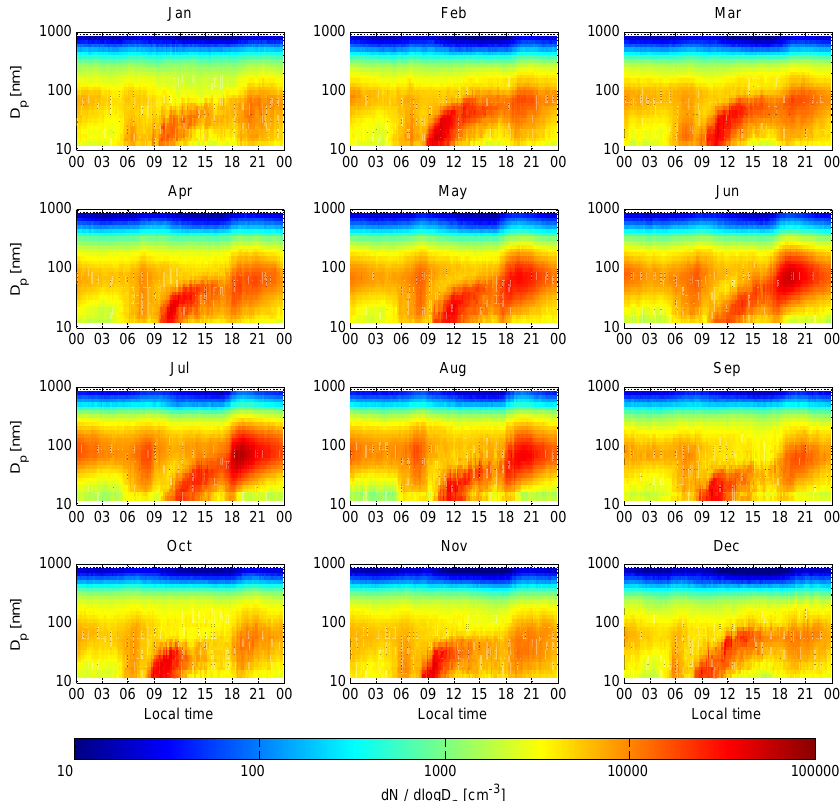
Fig. A2. Marikana monthly median diurnal variation. Note that the upper limit of the colour axis is increased from 10000cm − 3 in Fig. A1 to 100000cm − 3